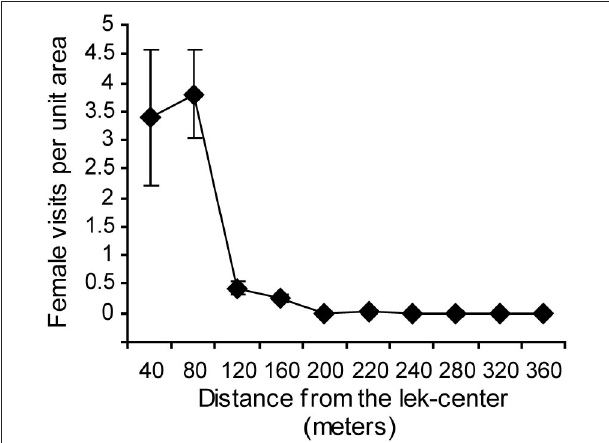
FIGURE 6 | Female visits were highest in the center of the lek and decreased toward the periphery. Means and standard errors based on 20 scan sessions are